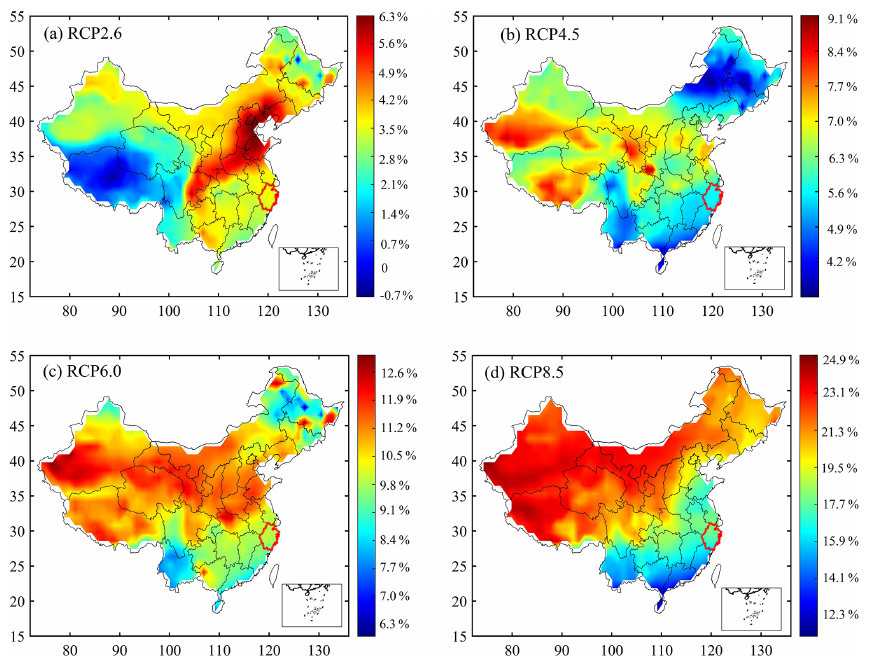
Figure 9. Global-warming-induced relative changes in waste treatment CH 4 EFs by the year 2100 for the (a) RCP2.6, (b) RCP4.5, (c) RCP6.0 and (d) RCP8.5 scenarios. Note the red boundary is Zhejiang